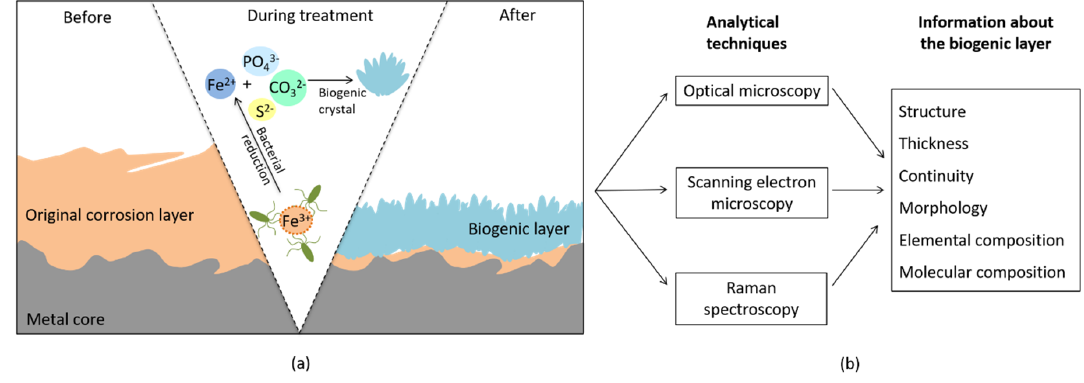
Figure 1. ( a ) Schematic cross-section of a corroded iron coupon submitted to bacterial treatment, showing microbial-induced modifications occurring; ( b ) the analytical methodology performed.